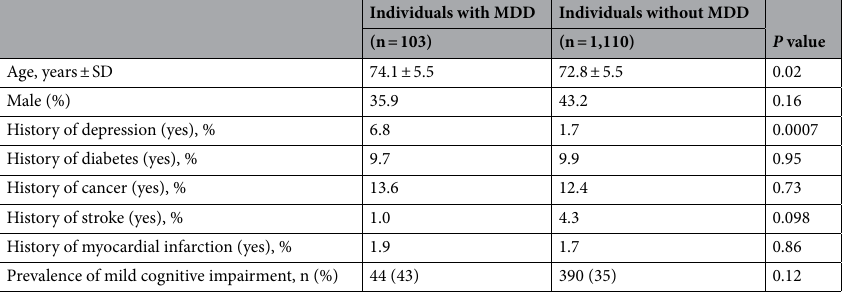
Table 1. Participant characteristics. The chi-square test was used for categorical variables and the t-test was used for continuous variables. A p value less than 0.05 was considered statistically significant. Abbreviation: MDD, major depressive